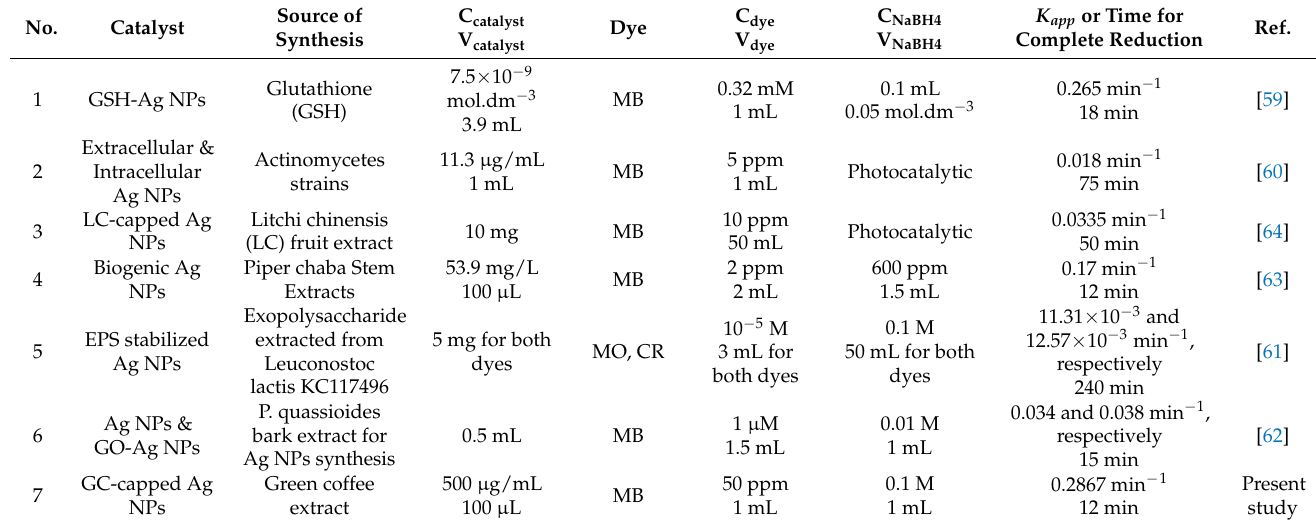
Table 1. Comparison between different biogenic silver-based nano-catalysts and our GC-capped Ag NPs concerning reaction and performance